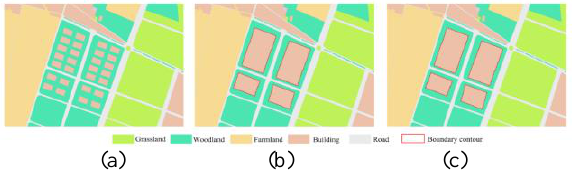
Figure 10. Comparison of merging results for the simple grid pattern. (a) Original data; (b) result of mixed integer programming; and (c) result of the method proposed in this paper.